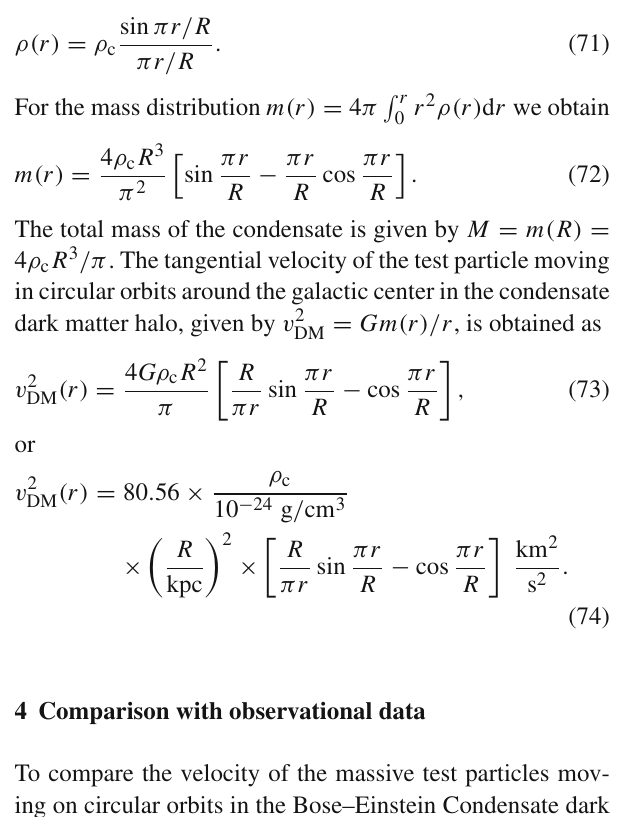
Fig. 3 Variation of the dimensionless tangential velocity V (ξ) as a function of the dimensionless radial distance ξ , for different model parameters.IntheleftFigure, θ = 0 . 01, γ = 2, (cid:2) = 0 . 3, ρ bc /ρ c = 0 . 2, while σ = 0 . 01 (dotted curve), σ = 0 . 015 (short dashed curve), σ = 0 . 02 (dashed curve), and σ = 0 . 025 (long dashed curve), respec- tively. In the right Figure, σ = 0 . 01, γ = 2, (cid:2) = 0 . 3, ρ bc /ρ c = 0 . 2,